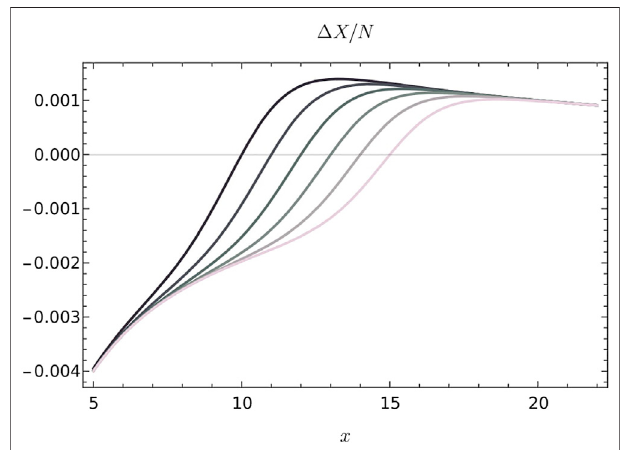
(cid:2) μ (cid:2) μ , r (cid:2) r (cid:2) 0, j 1 j 2 j 2 1